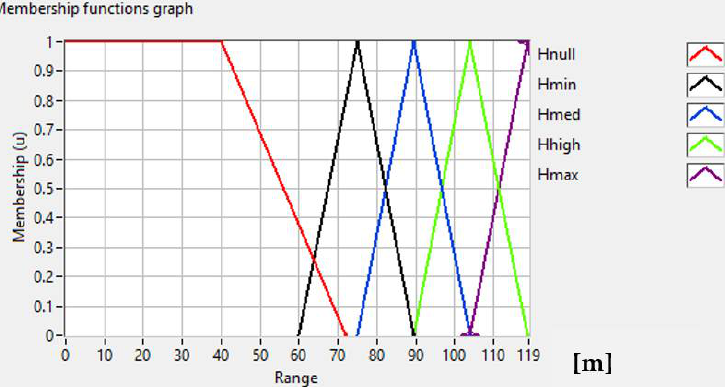
Figure 6. Membership functions of the input variable height of the hydraulic fuzzy system. X-axis range in (m).